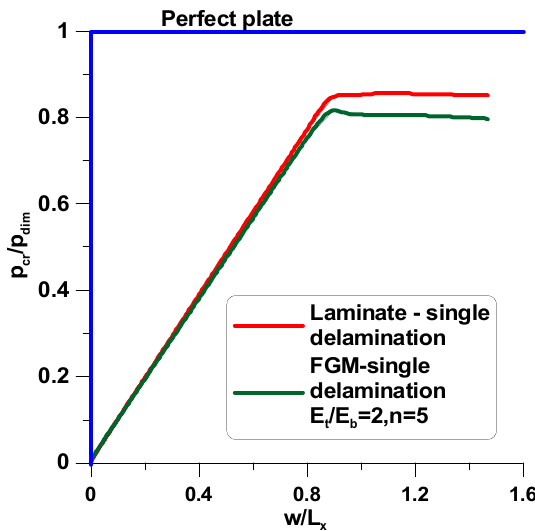
Figure 19. Pre- and post-buckling deformations of compressed plates with delaminations (w is a normal deflection at the middle of the plate).